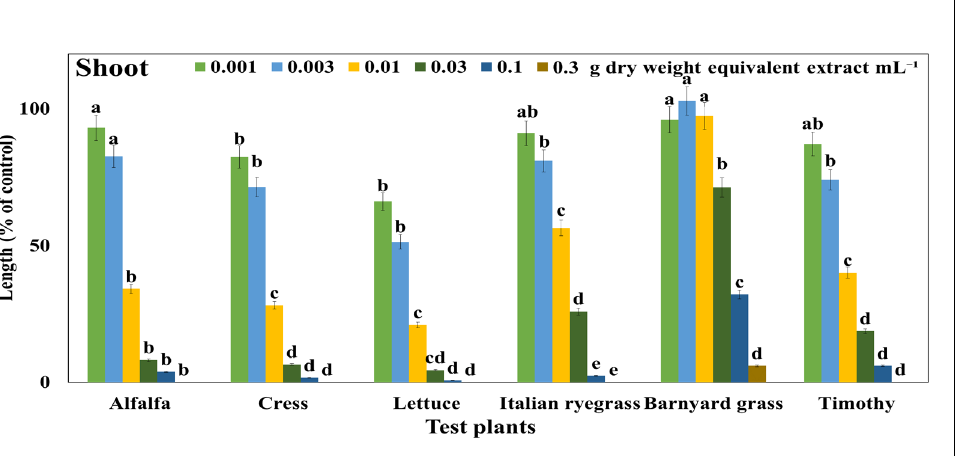
Figure 2. Shoot growth inhibition of the six test plants by A. reticulata leaf extract treatment at different concentrations. Mean ± SE of 2 separate experiments replicated 3 times ( n = 60). Standard error of the mean is represented by vertical bars. Differences between control and A. reticulata treatment are represented by different letters (Tukey’s HSD at p ≤